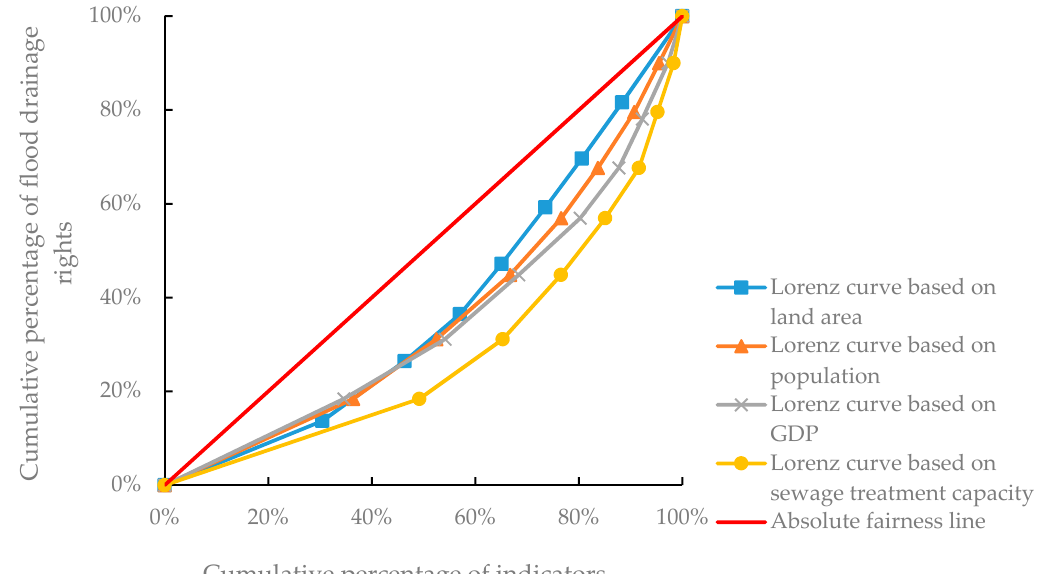
Figure 5. Lorenz curve of each evaluation index.